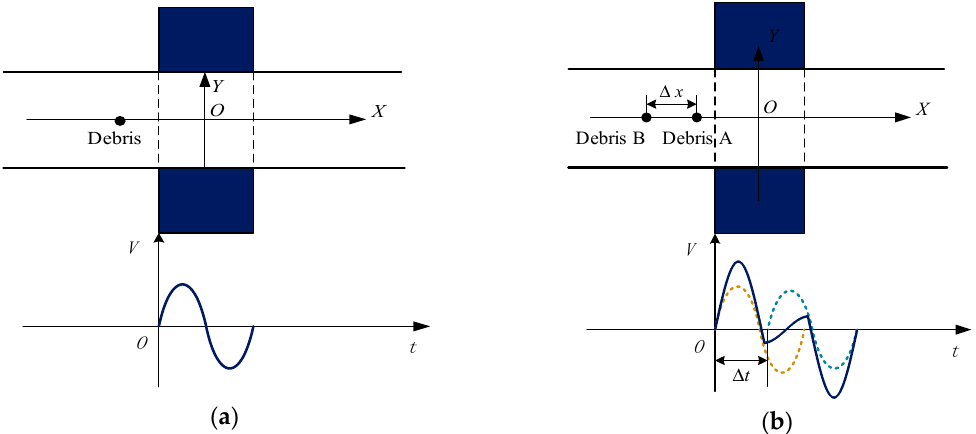
Figure 2. Debris passing the sensor and the signal generated under different situations: ( a ) Single debris particle passing through the sensor; ( b ) Two debris particles passing through the sensor.